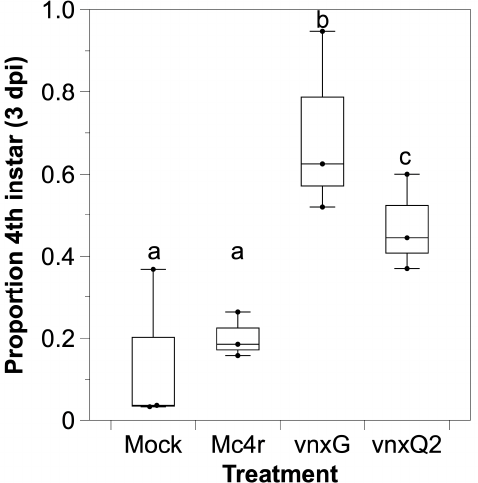
Figure 3. Vinnexin expression delays caterpillar development. Mock and recombinant virus infected caterpillars were maintained and observed for 3 days during which developmental stage (4th or 5th instar) was recorded daily. The proportion of 4th instar larvae was calculated and compared. Su- perscript letters indicate significant difference at p < 0.05.